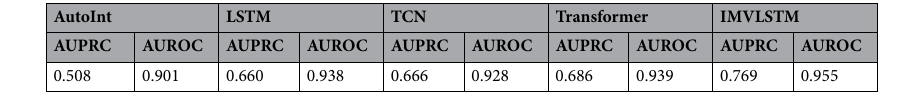
Table 2. Classification performance of all considered deep